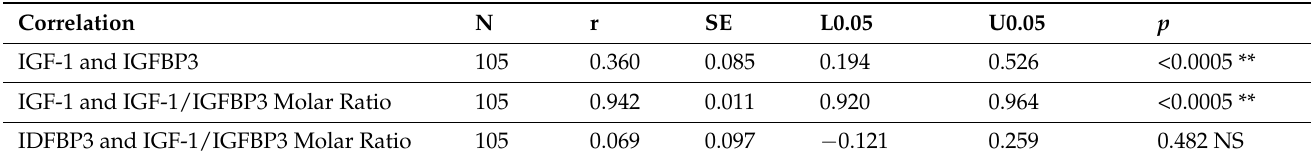
Table 4. Correlation(r) among IGF-1, IGFBP3, and the IGF-1/IGFBP3 molar ratio.